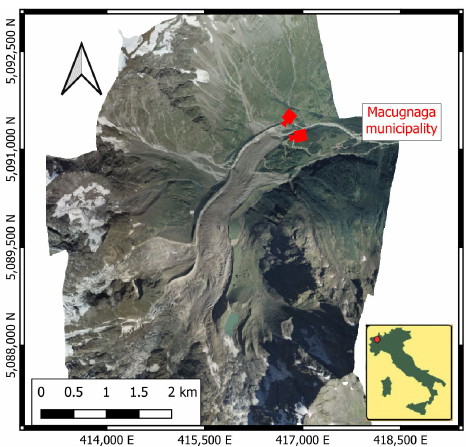
Figure 6. Location of the Belvedere Glacier. The position of the two cameras is marked with red camera